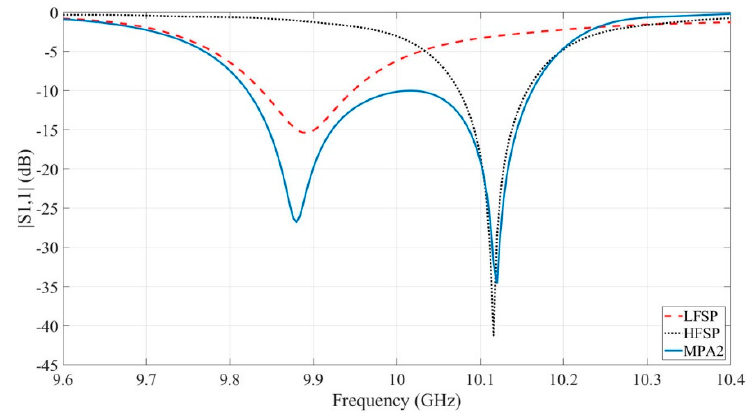
Figure 5. Simulated reflection coefficient for LFSP, HFSP, and MPA2.